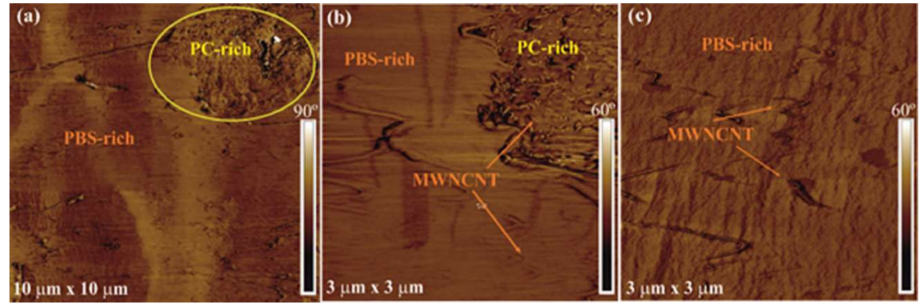
Figure 7. ( a ) Low and ( b ) high magnification AFM phase images for the 93/(6/1) w / w PBS/(PC/MWCNTs) nanocomposite, and high magnification AFM phase image of the PBS-rich matrix ( c ). The yellow ellipses (see ( a )) indicate the PC-rich